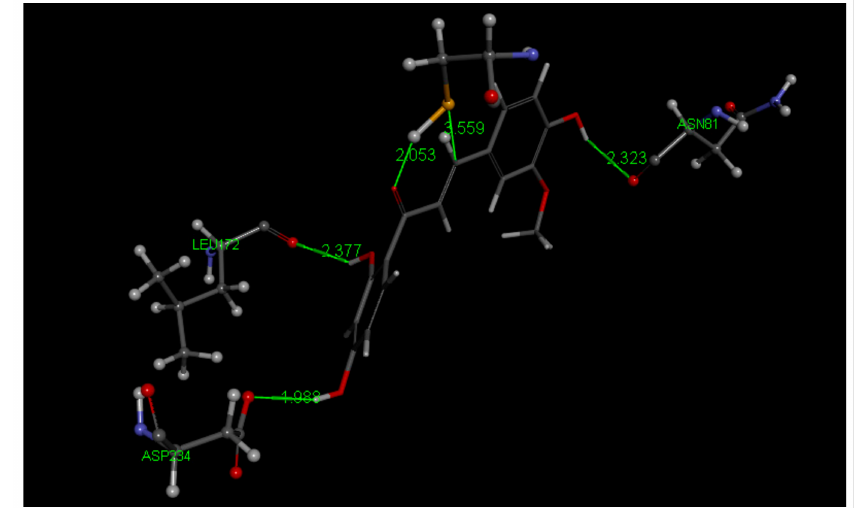
Figure 23. Three-dimensional (3D) interaction of Homobutein ( 3 ) with the receptor 3BPF Falcipain-2, pose 6. Compared to Butein, S(Cys42) shows a greater separation to the chalcone, 3.559 Å to the ethenyl β carbon. Three amino acids give stability to this arrangement through H bonds. O(carbonyl) shows a H-bond to H[S(Cys42)], 2.053 Å. Upon calculating binding energy ( − 16.7 kcal/mol) the arrangement is confirmed, showing S—C( β ethelnyl) separation of 3.400 Å, while O(carbonyl)— H[S(Cys42)] distance becomes longer, 2.458 Å. After minimization H bonds between Homobutein and amino acids Asn81, Leu172 and Asp234 show shorter lengths, 2.183 Å, 2.344 Å and 1.792 Å, respectively. The H atom bound to the ethenyl β carbon (shown in ball style) seems to hinder the approach of S(Cys42) and so no covalent bond seems feasible for